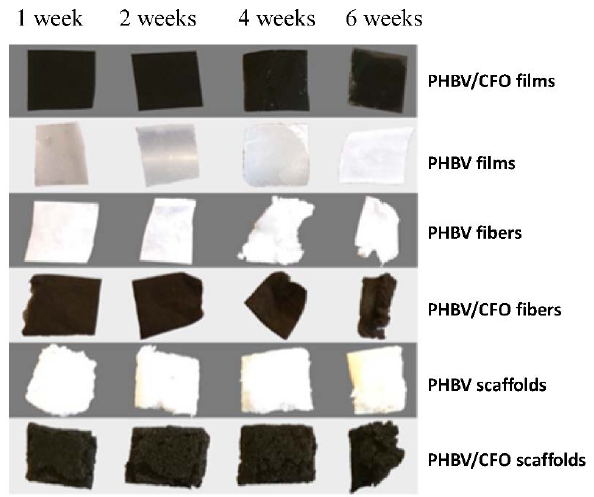
Figure 2. Poly(3-hydroxybutyrate-co-hydroxyvalerate) (PHBV) and PHBV / cobalt ferrite (CFO) films, sca ff olds and fibers after 1, 2, 4 and 6 weeks immersion in simulated body fluid (SBF) at 37 ◦